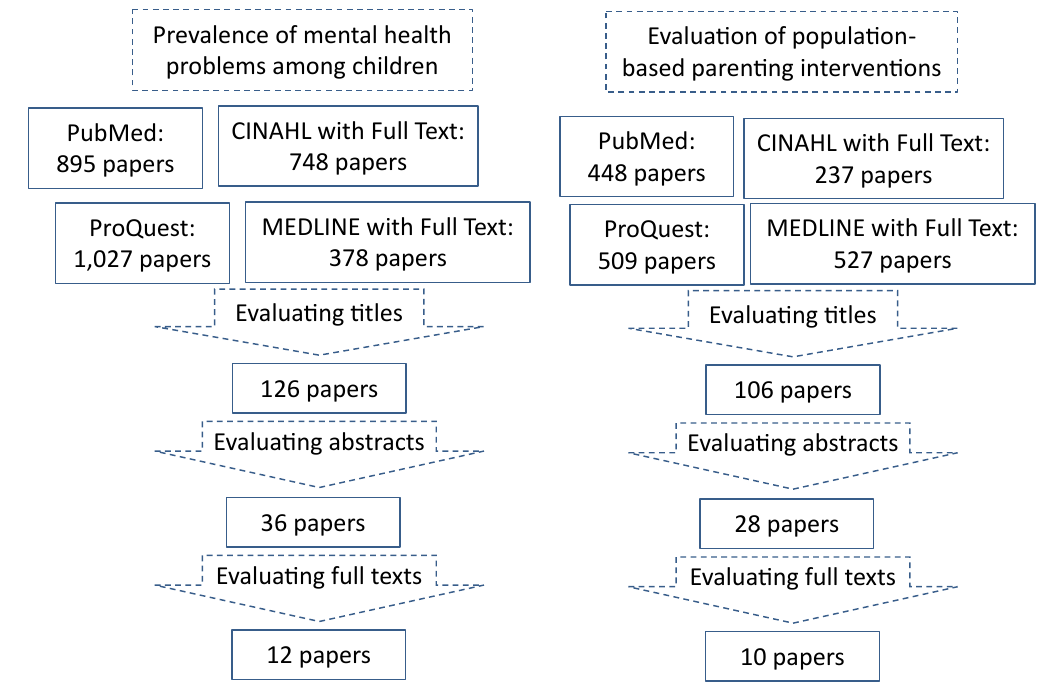
Figure. Search results and